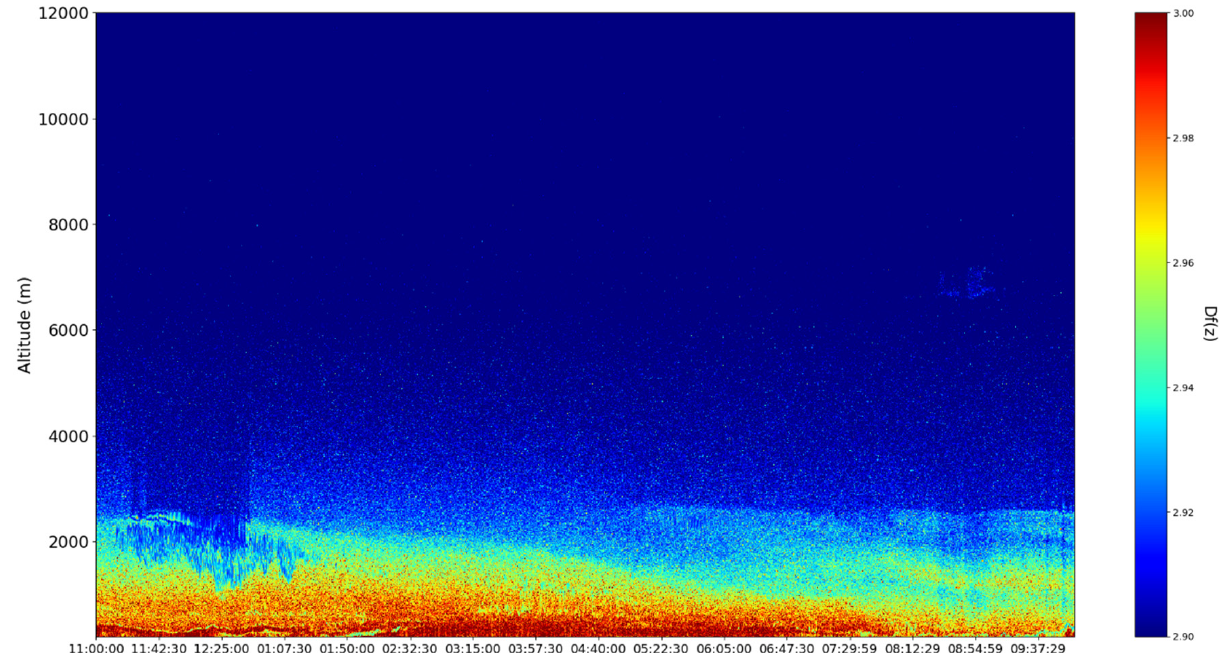
Figure 19. D F timeseries, λ = 1064 nm, Galat